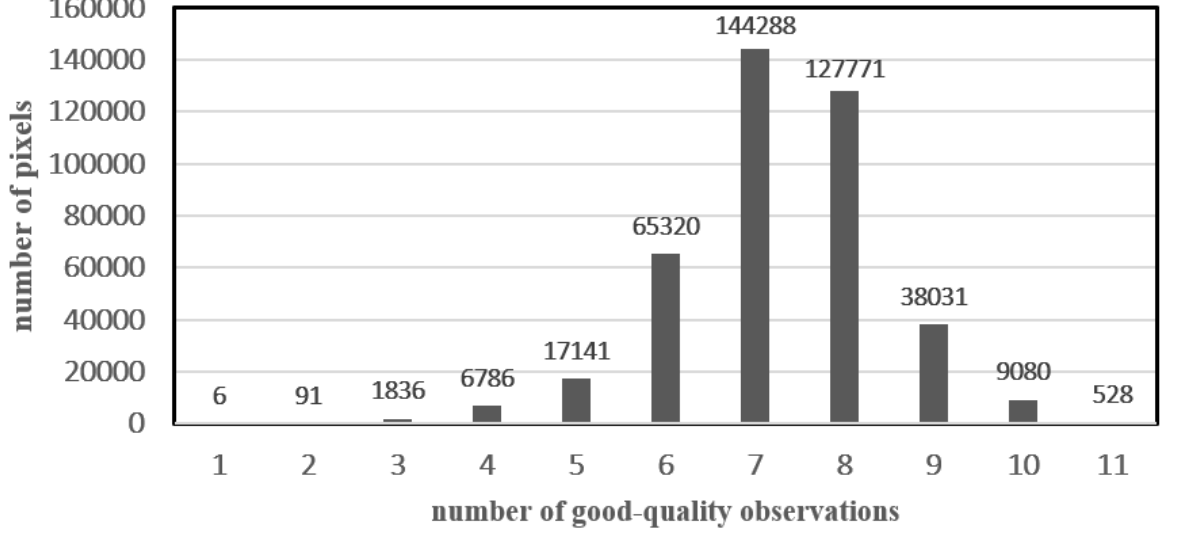
Figure A3. Mangrove distribution maps in Nam Dinh between 1995 and 2020.